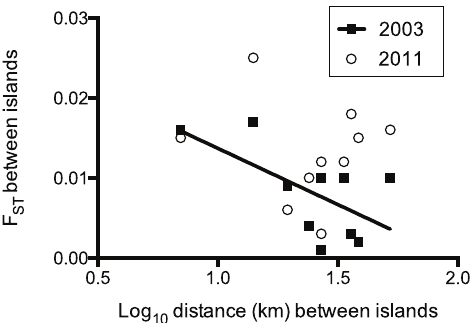
Figure 4. Isolation by distance analysis for western tent caterpillar populations in 2003 and